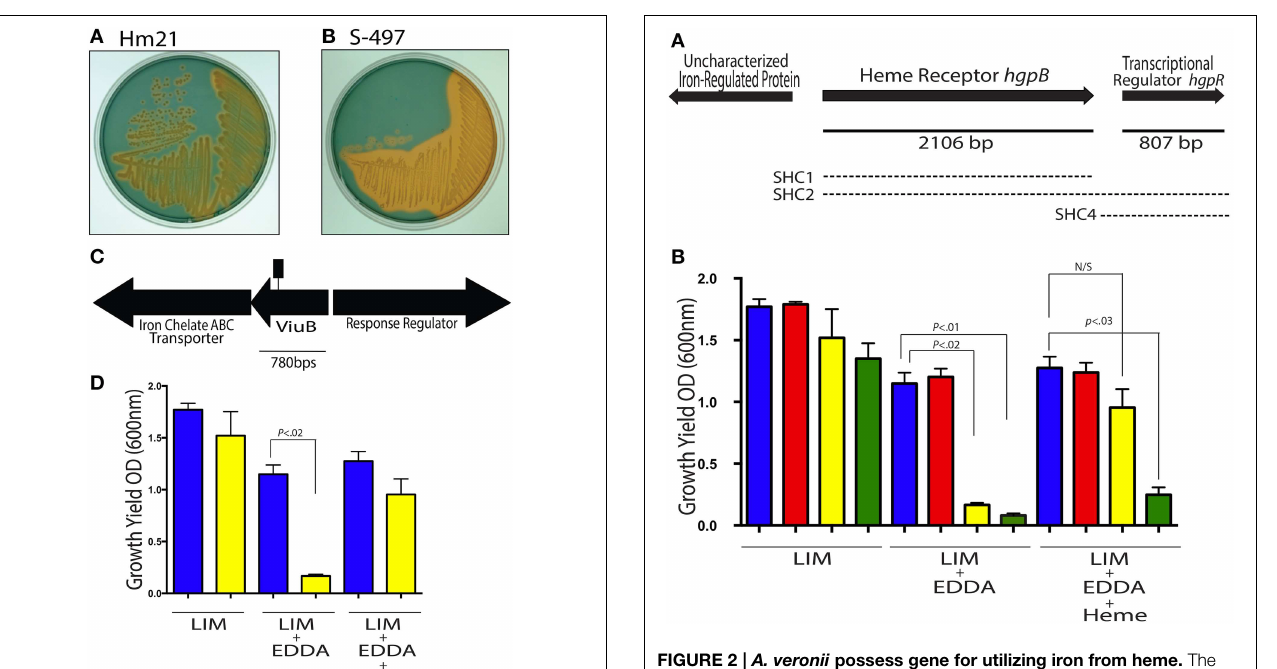
FIGURE 2 | A. veronii possess gene for utilizing iron from heme. The heme receptor locus from HM21 is shown (A) . The solid line indicates length of the gene. The three regions used for complementation with a Tn 7 are represented by the dashed lines, the upper dashed line (SHC1), the middle dashed line (SHC2), and the bottom dashed line (SHC4). (B) The growth yield of Hm21R (blue); H-890 (red), the hgpB mutant; S-497 (yellow), the siderophore mutant; and SH-894 (green), the double mutant was determined by measuring the OD 600 24h after inoculation in LIM, LIM (150 µ M EDDA), or LIM (150 µ M EDDA and 50 µ g/ml hemin). The statistically significant difference between the parent strain and each mutant was performed using a Mann–Whitney test. This revealed the requirement of the hgpB for utilizing hemin as an iron source in the presence of